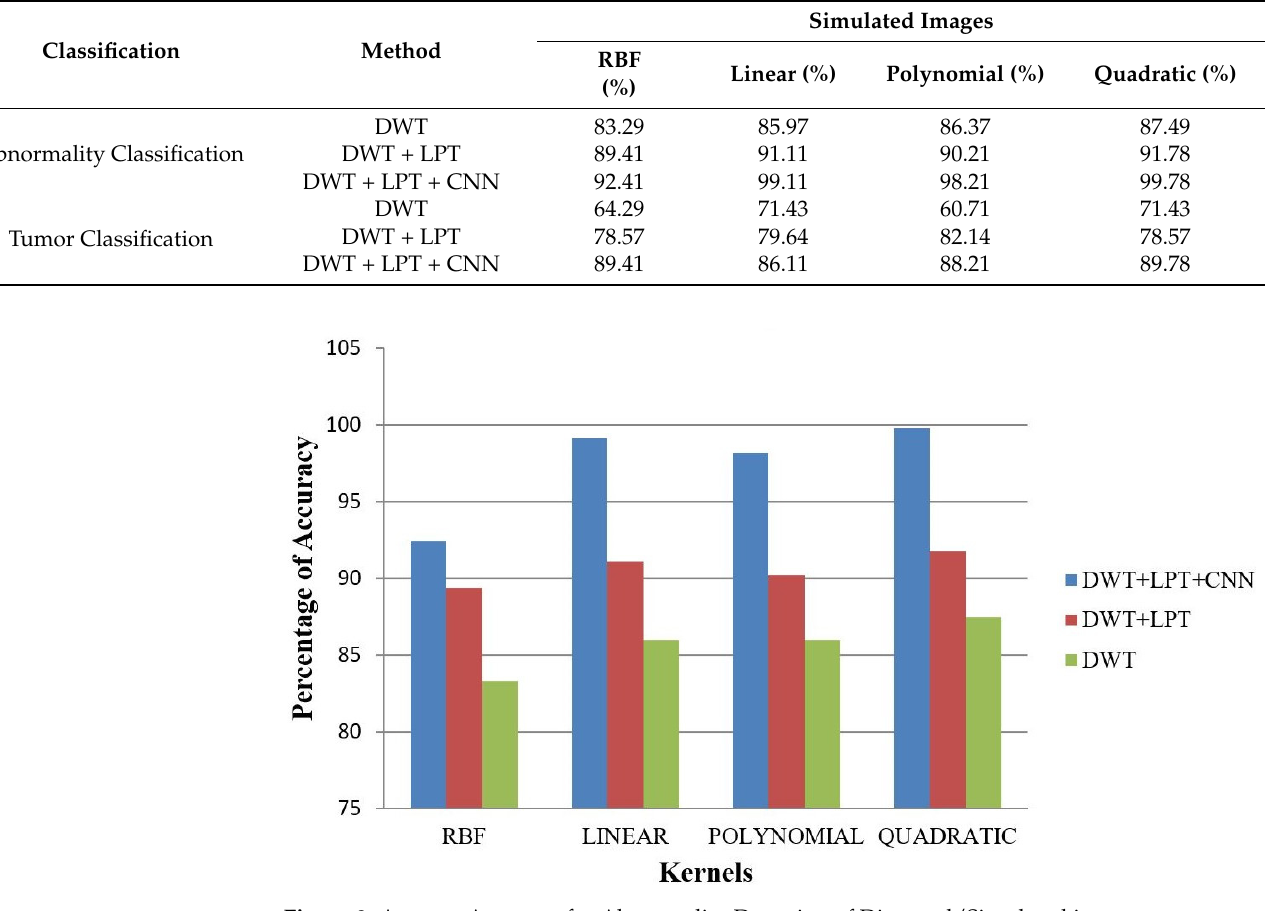
Figure 8. Average Accuracy for Abnormality Detection of Distorted/Simulated images.